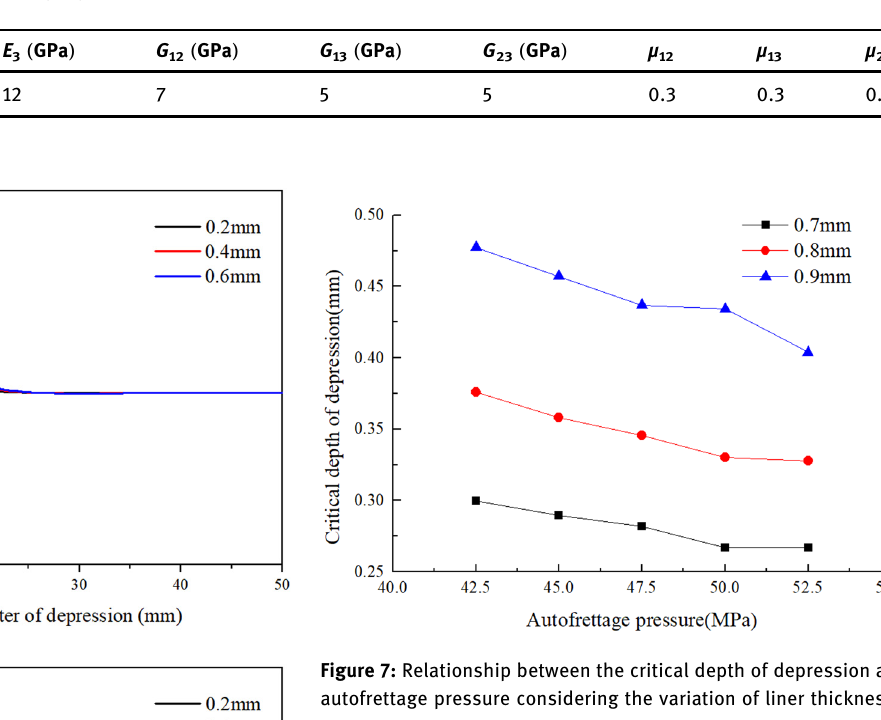
Table 2: Sti ff ness properties of T700/epoxy